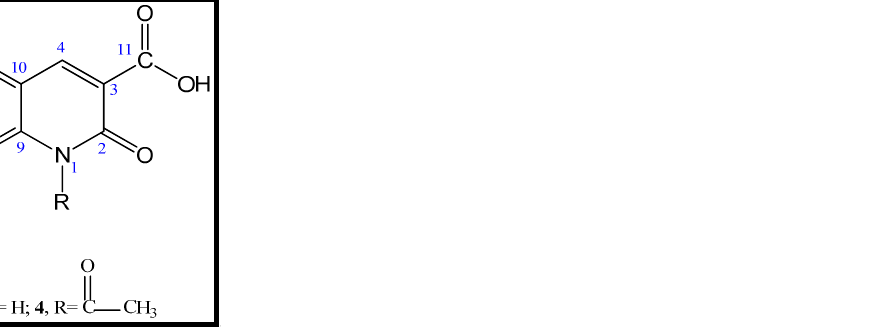
Figure 4. The structure of 1- N -(substituted)-azacoumarin-3- carboxylic acids (compounds 3 and 4 )